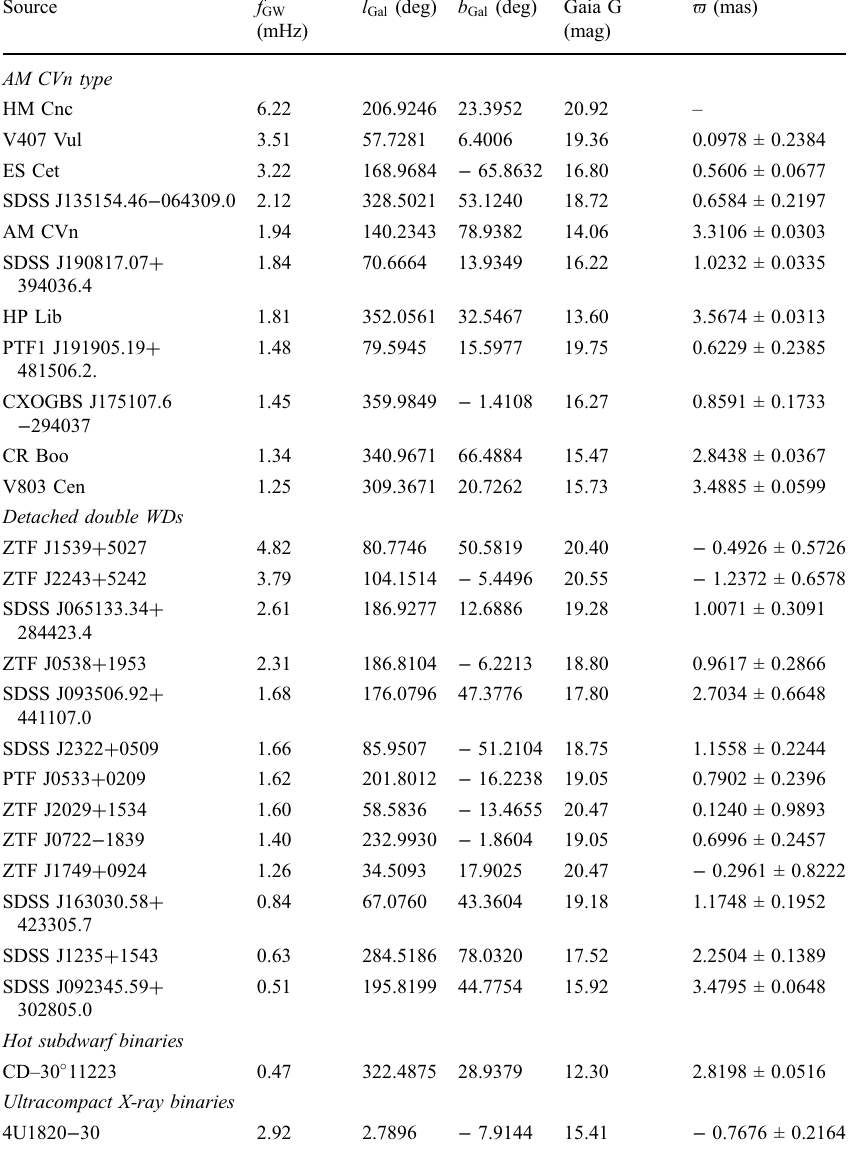
Table 2 Measured EM properties (Galactic coordinates, GW frequency, magnitudes and parallaxes from Gaia early data release 3 (Gaia Collaboration et al. 2021) of the known veri fi cation binaries which reach